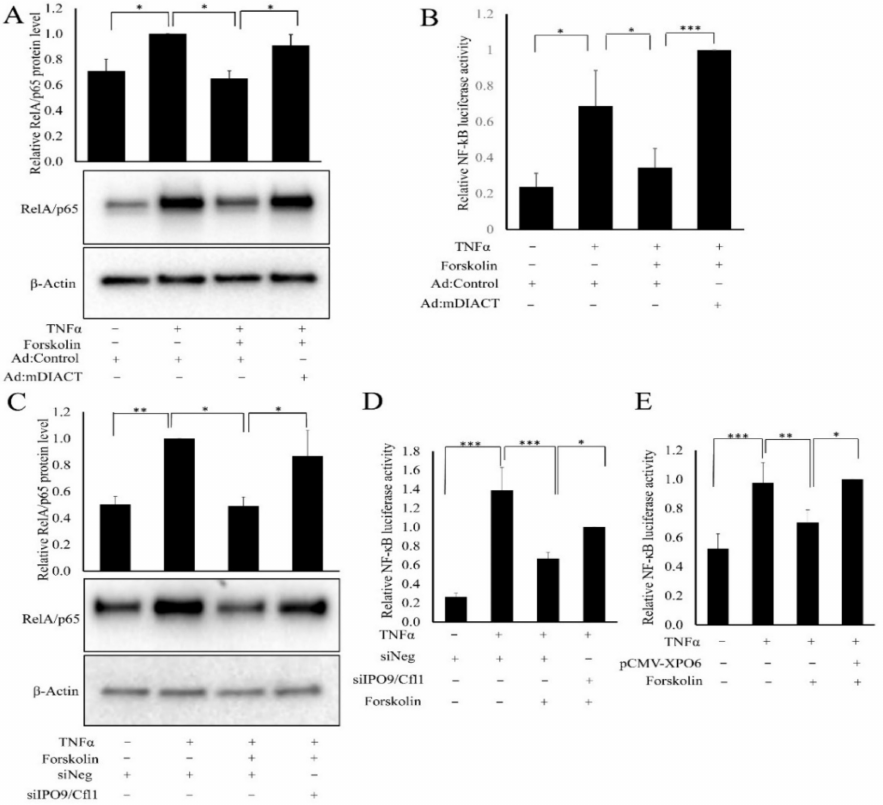
Figure 7. Reducing nuclear actin monomer levels rescues RelA/p65 protein levels and NF- κ B activity in cells with elevated cAMP signalling. VSMCs were infected with either Ad:Control or Ad: mDIACT. The next day, cells were serum-starved and stimulated with TNF α and forskolin for 6 h, as indicated. Total cell lysates were analysed for RelA/p65 and β -actin protein levels by Western blotting and densitometry analysis (( A ); n = 5). Cells were transfected with NF- κ B-LUC and either a control or mDIACT expression plasmid (( B ); n = 4). Serum-starved cells were stimulated with forskolin and TNF α for 6 h, as indicated, and luciferase activity quantified. VSMCs were transfected with either non-targeting siRNA (siNEG) or siRNA targeting IPO9 and CFL1 (siIPO9/Cfl1). Serum-starved cells were stimulated with forskolin and TNF α for 6 h, as indicated. Total cell lysates were analysed for RelA/p65 and β -actin protein levels by Western blotting and densitometry analysis (( C ); n = 5). Cells were transfected with NF- κ B-LUC and either siNEG or siIPO9/CFL1. Serum-starved cells were stimulated with forskolin and TNF α for 6 h, as indicated, and reporter activity measured (( D ); n = 9). Cells were transfected with the NF- κ B-LUC and either control or Exportin-6 (XPO6) expression plasmids. Serum-starved cells were stimulated with forskolin and TNF α for 6 h, as indicated, and luciferase activity quantified (( E ); n = 6). ANOVA with Student Newman Keul’s post hoc test. Data are mean ± SEM. *, ** and *** indicate p < 0.05, 0.01 and 0.001,